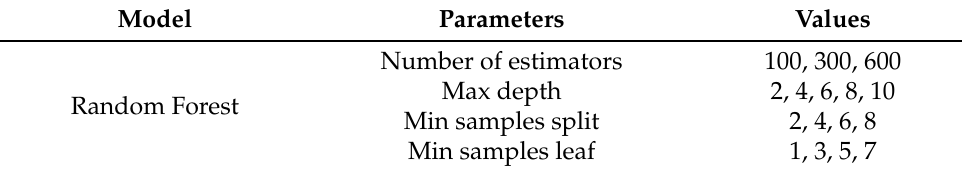
Table 7. Grid of parameters used for random forest